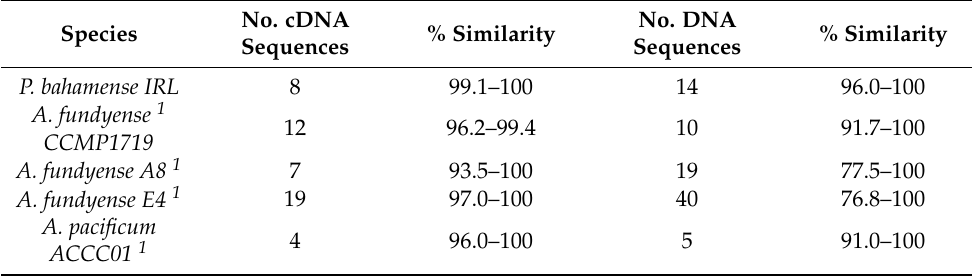
Table 2. Percent similarity between genomic and cDNA sxtA4 sequences for P. bahamense . No. cDNA Species %